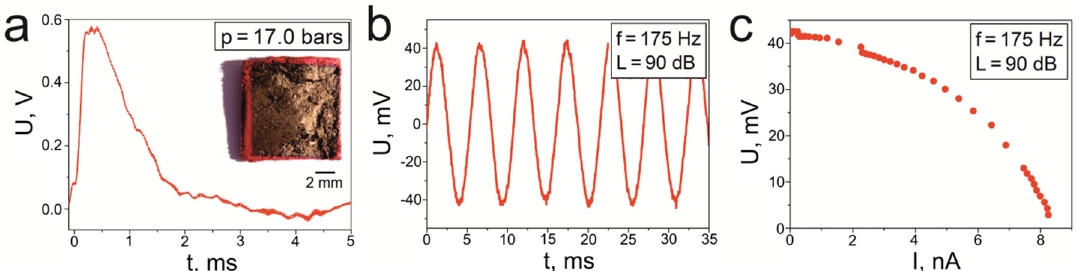
Figure 17. The output voltage from the cellulose/SbSI sandwich (sample S9) for ( a ) an applied pressure of 17.0 bars and ( b ) input acoustic waves with a frequency of 70 Hz and a sound pressure level of 90 dB ( c ) The output voltage from S9 against the current intensity for different load resistances and acoustic waves. The inset of ( a ) is a photograph of sample S9.